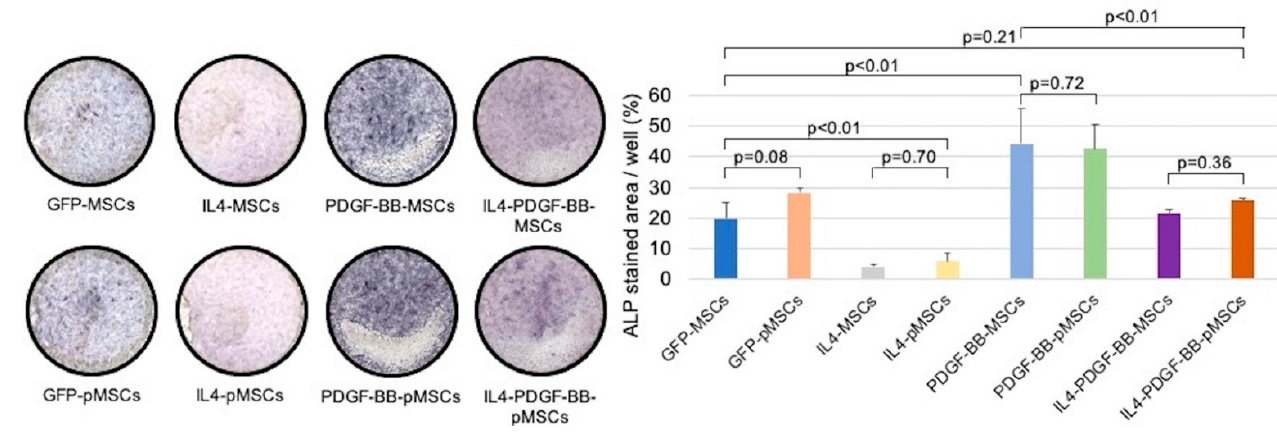
Figure 5. Alkaline phosphatase-staining in all eight groups 2 weeks after seeding. The percentages of stained area in the GFP-MSC, GFP-pMSC, IL4-MSC, IL4-pMSC, PDGF-BB-MSC, PDGF-BB-pMSC, IL4-PDGF-BB-MSC, and IL4-PDGF-BB-pMSC groups were 19.8 ± 5.3%, 28.3 ± 1.4%, 4.3 ± 0.7%, 6.0 ± 2.4%, 44.2 ± 11.7%, 42.5 ± 8.1%, 21.4 ± 1.5%, and 25.7 ± 1.0%, respectively. Abbreviations: ALP, alkaline phosphatase.